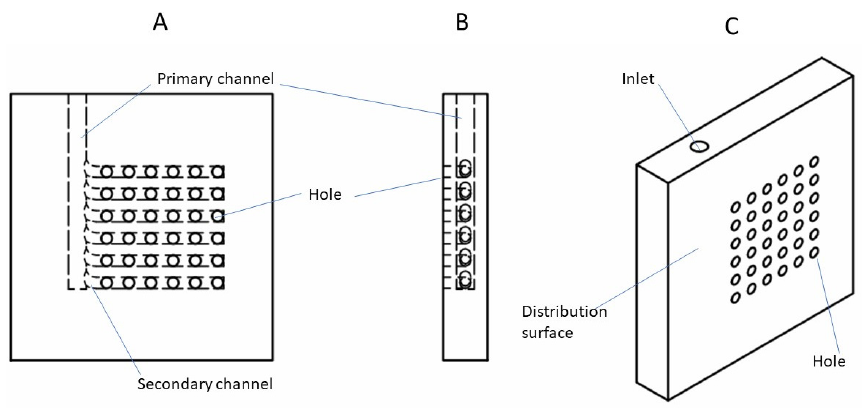
Figure 4. ( A ) Top view of flow distribution plate. ( B ) Side view of flow distribution plate. ( C ) Iso- metric view of flow distribution